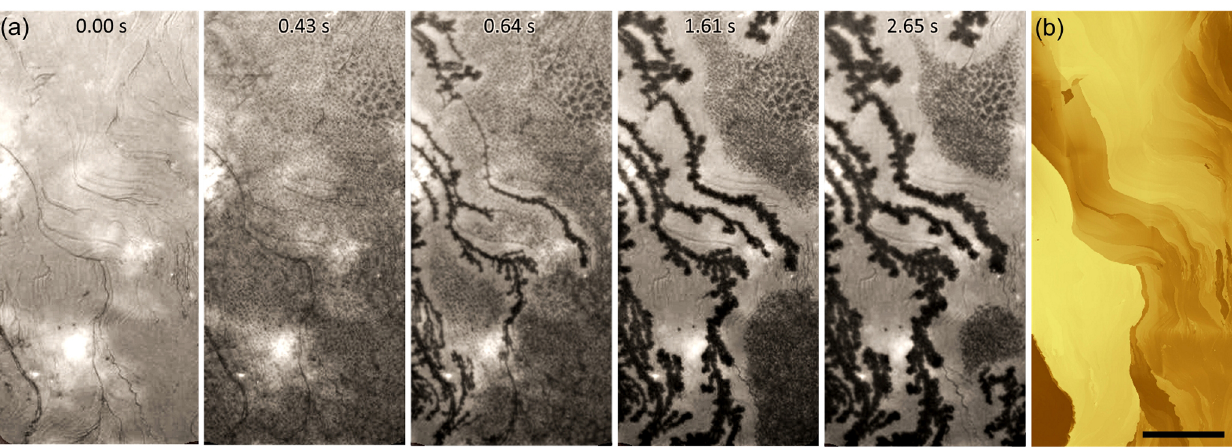
Figure 3. Ice growth on the feldspar surface at − 29 . 5 ± 0 . 5 ◦ C and AH in = 0 . 80 ± 0 . 08gm − 3 . (a) Video frames at the noted times show the progression from a dry surface (0.00s), to surface water condensation (0.43s), and finally to propagation of ice across the surface. From 0.64 to 2.65s the denuded zone (dehydrated halo) around the ice filaments expands with ice growth. (b) AFM mosaic of the same area as in (a) where lighter color indicates higher surface topography. Note the prominent step edges follow the same path as many of the ice filaments. Scale bar 100µm. Accompanying video can be found in Friddle and Thürmer